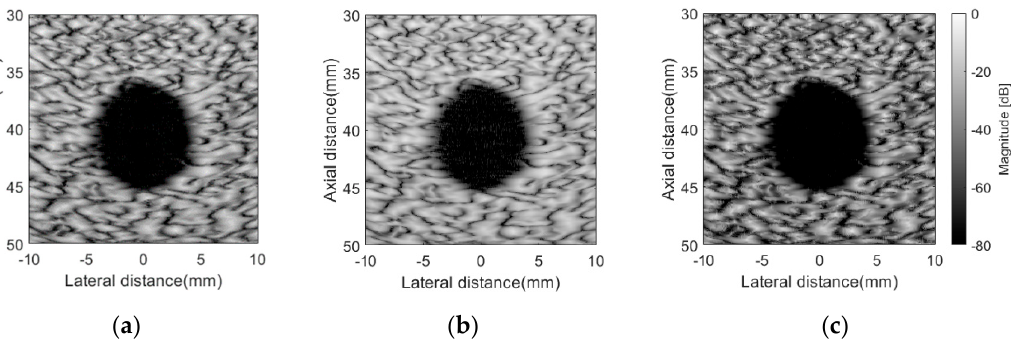
Figure 9. Beamforming responses of simulated cyst target with different parameters. ( a ) GSC-CROSS (L = 24, Δ = 20); ( b ) GSC-CROSS (L = 16, Δ = 20); ( c ) GSC-CROSS (L = 24, Δ = 100). The dynamic range of image is 80 dB. Table 5. Contrast of beamforming responses of GSC-CROSS with different parameters.